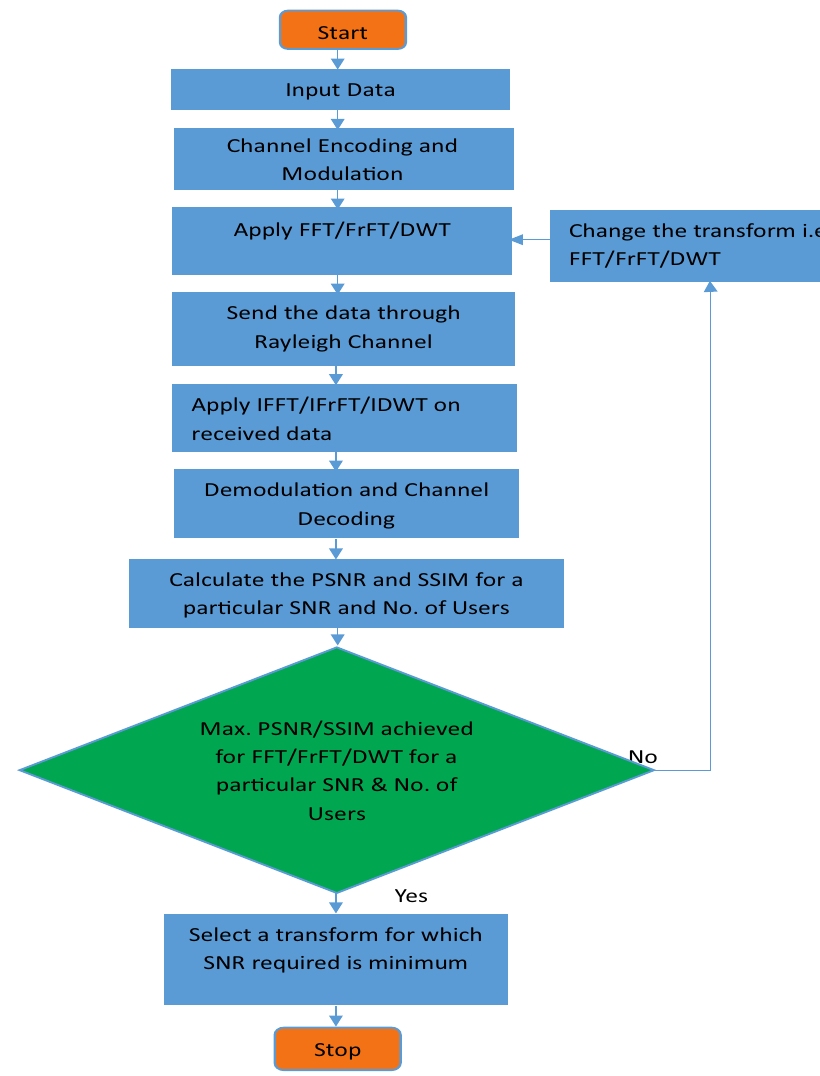
Figure 3. A flowchart of the proposed OFDM Massive MIMO